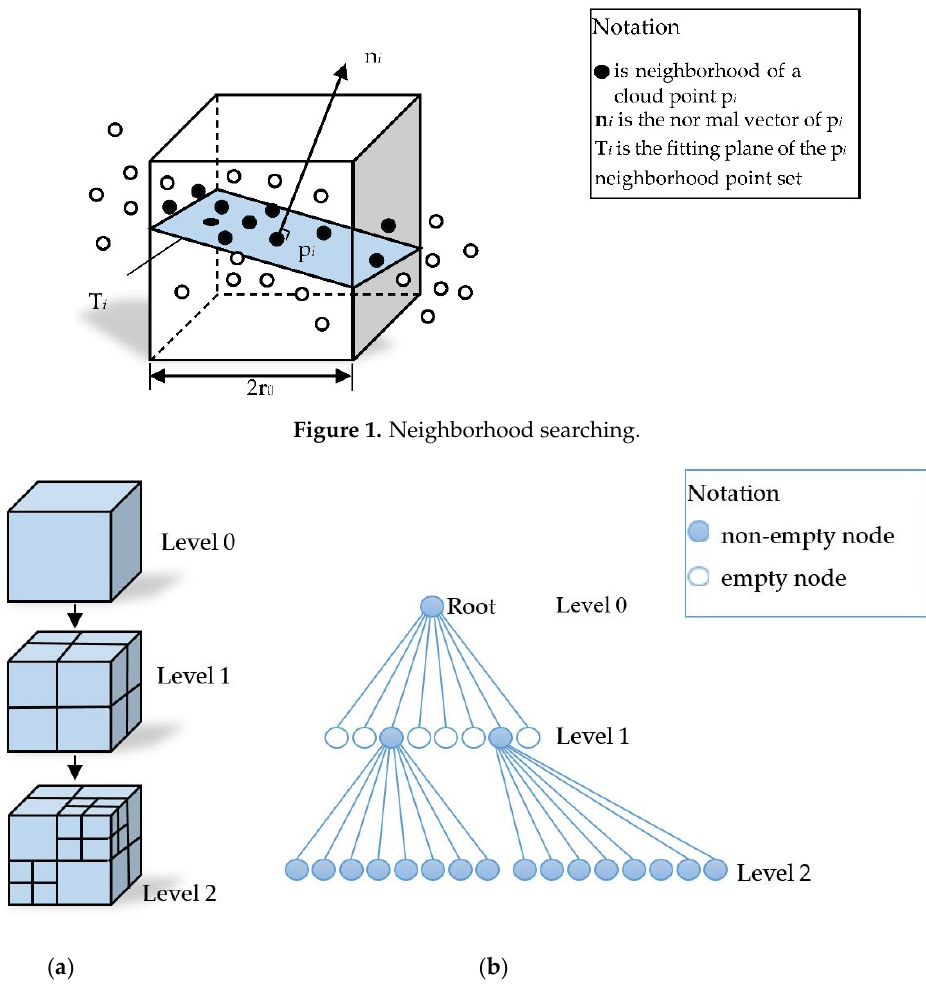
Figure 2. Octree. ( a ) Space decomposition, ( b ) Octree hierarchical structure.